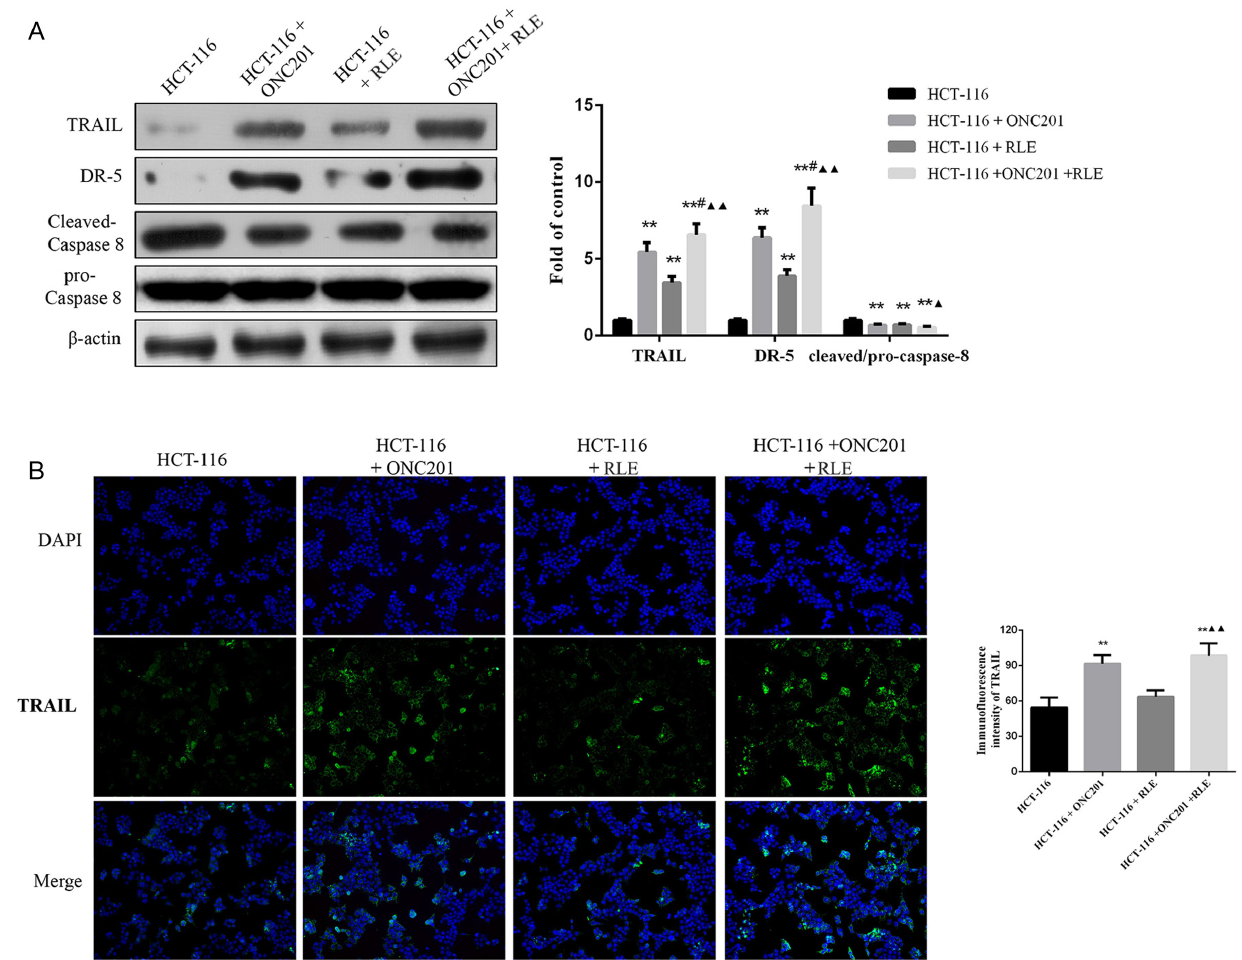
Figure 4. Effect of RLE and ONC201 co-treatment on TRAIL, DR5, cleaved caspase 8, and pro-caspase 8 expression levels. (A) Western blot analysis for the detection of protein expression of TRAIL, DR5, cleaved caspase 8, and pro-caspase 8. (B) Immunofluorescence expression of TRAIL in HCT116 cells. * P < .05, ** P < .01 vs. the HCT116 group; # P < .05, ## P < .01 versus the HCT116 + ONC201 group; ▲ P < .05, ▲▲ P < .01 vs. the HCT116 + RLE group. RLE, raw lacquer